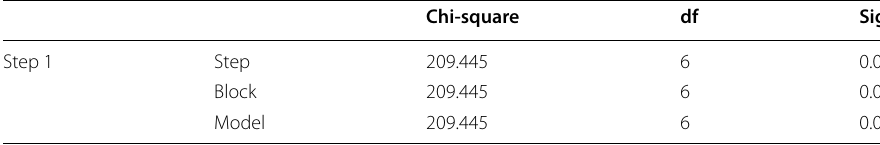
Table 4 Omnibus tests of model coefficients